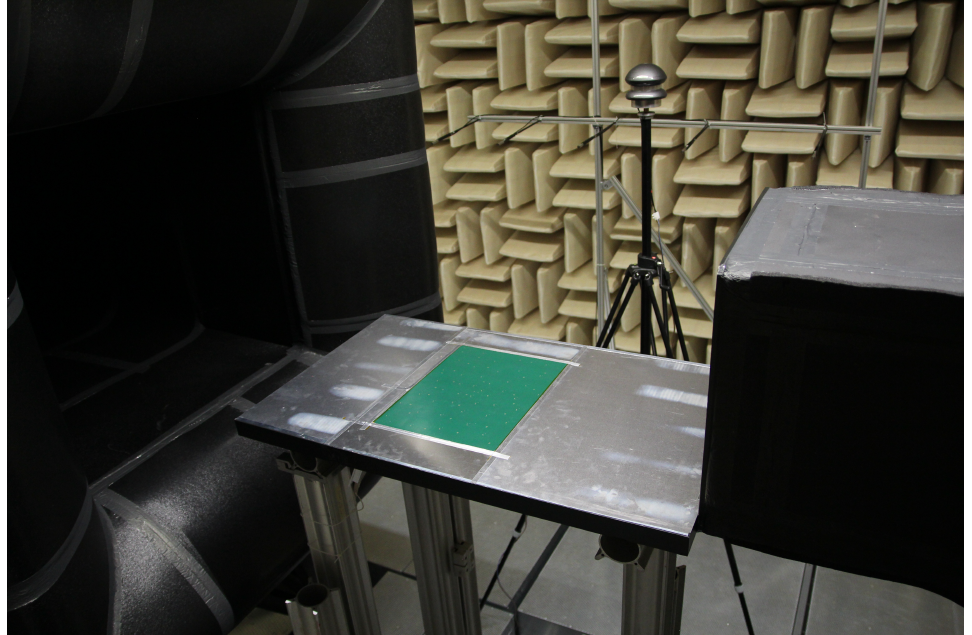
Figure 7. Photo of the measurement setup for the first tests under flow conditions. The MEMS array is mounted on the plate that is used as an extension of the bottom wind tunnel